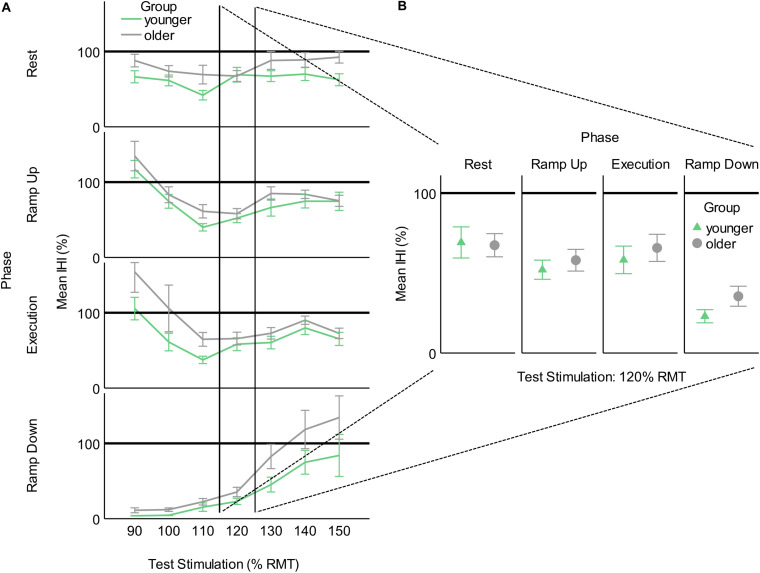
Interhemispheric inhibition calculated as a percentage of conditioned MEP to unconditioned MEP for younger and older participants across task phases. (A) As a function of test stimulation (percent of resting motor threshold [rMT]). (B) At the traditional test stimulation intensity of 120% rMT. This figure illustrates the added information provided by utilizing MEP recruitment slopes gathered across multiple stimulation intensities. Values below 100% indicate inhibition and values above 100% indicate facilitation.